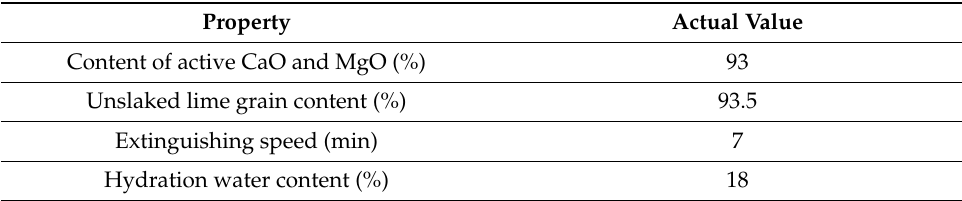
Table 5. Characteristics of lump quicklime.